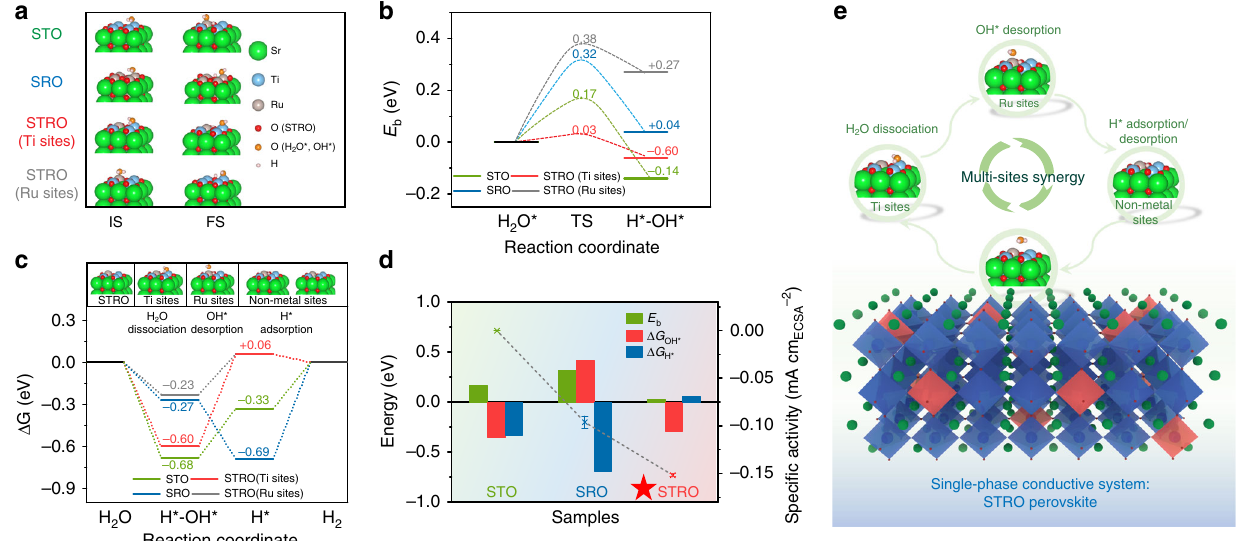
Fig. 6 DFT calculations and electrocatalysis mechanism. a Surface structure con fi gurations at the IS (H 2 O) and FS (H * + OH * ) of STO, STRO, and SRO in the prior water-dissociation process. b The energy barrier for breaking the OH – H bond at the transition state (TS) in the water-dissociation process. c Gibbs free energy diagrams of the alkaline HER pathway on STO, STRO, and SRO. The inset above is the surface con fi guration of STRO at different stages of the reaction. d The relationship between the computed E b , Δ G H* , Δ G OH* values, and the measured activity on STO, STRO, and SRO catalysts. e Schematic illustration of synergistic catalysis mechanism for alkaline HER on the single-phase STRO perovskite oxide. The red and blue octahedra represent RuO 6 and TiO 6 , respectively.